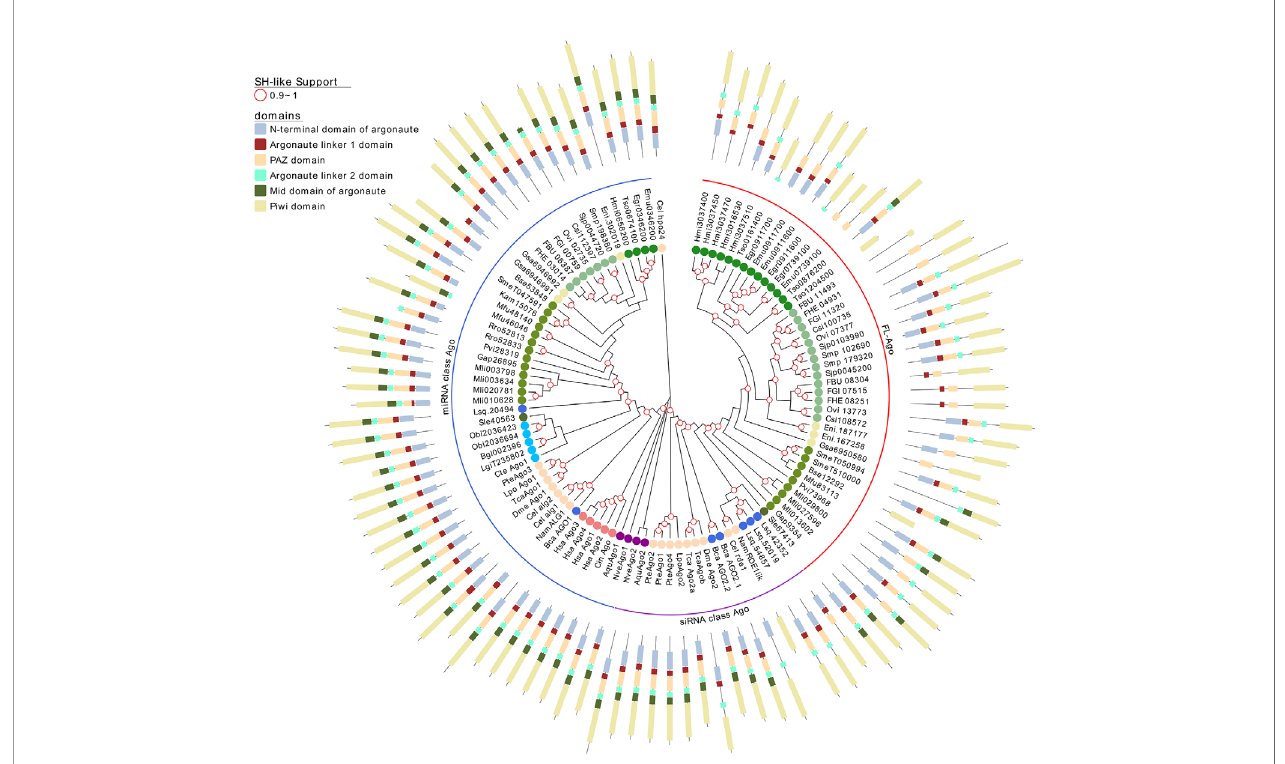
FIGURE 3 | A maximum likelihood tree of canonical Argonaute proteins and FLAgos. SH-like approximate likelihood ratios are indicated. Conserved protein domains were predicted with HMMScan. Blue, purple and red arches correspond to miRNA Ago-class, siRNA Ago-class and FL-Agos, respectively. Abbreviations are as indicated in Figure 2